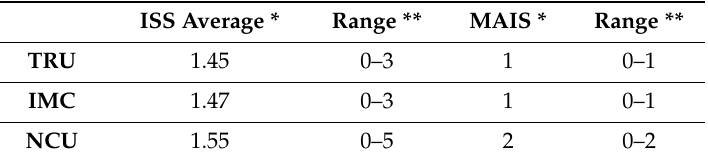
Table 4. ISS Average and MAIS.